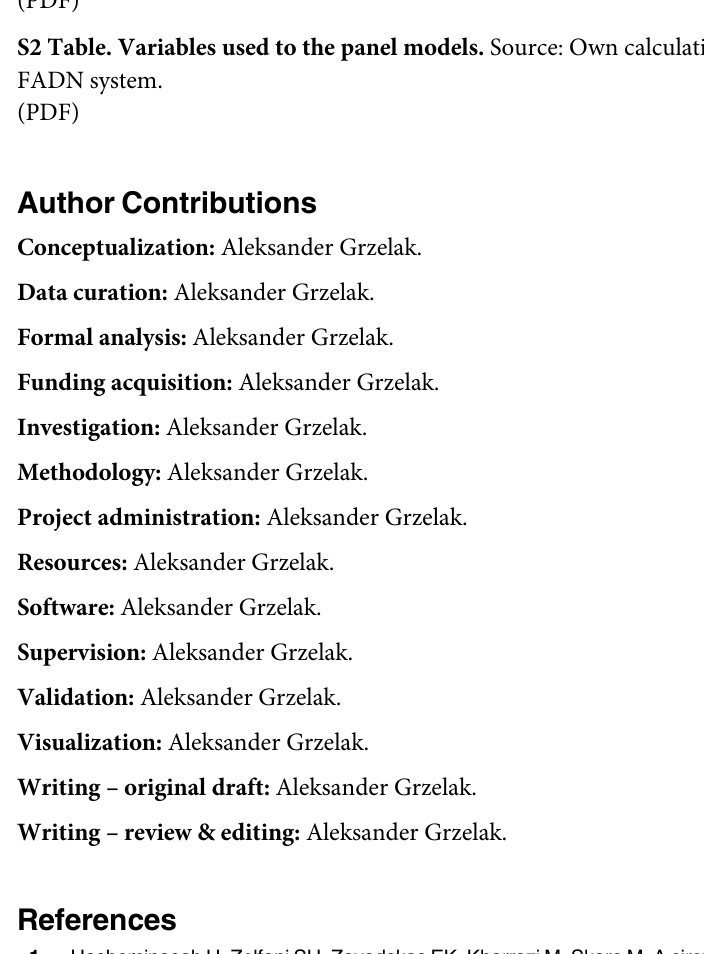
S1 Table. Income and assets in farms (FADN system) in the EU countries (23). Source: Own calculation based on data of the FADN system. S2 Table. Variables used to the panel models. Source: Own calculation based on data of the FADN